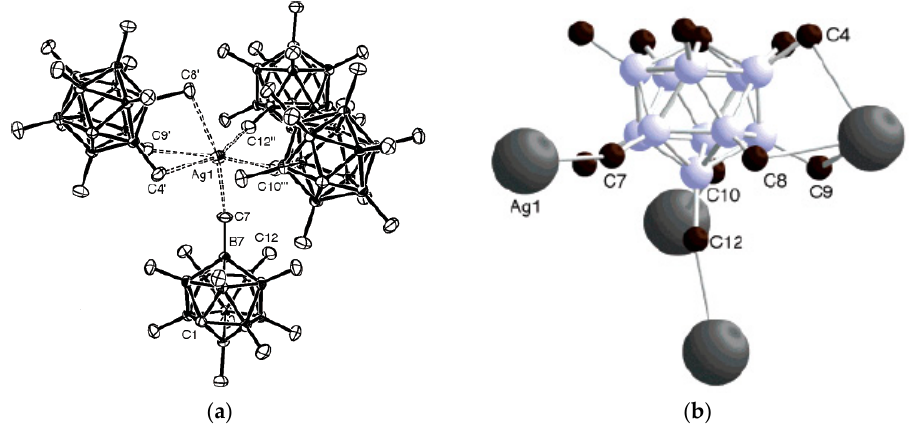
Figure 82. The coordination sphere of the Ag atom in {Ag[HCB 11 Me 11 ]} n ( a ) and the coordination sphere around the carborane anion in {Ag[HCB 11 Me 11 ]} n ( b ). Reprinted with permission from reference [104]. Copyright © (2004) American Chemical Society.